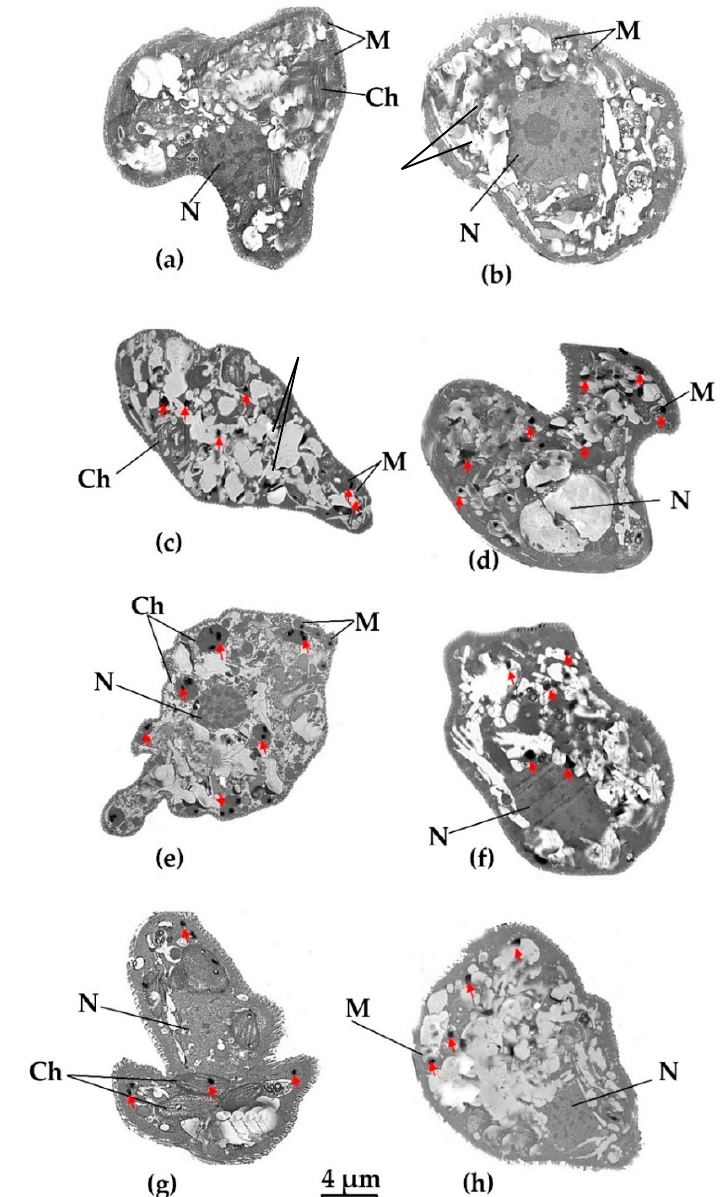
Figure 5. Visualization of heavy metal accumulation in E. gracilis strains using transmission electron microscope (TEM). ( a ) Z-strain control- untreated cell; ( b ) Zm-strain control- untreated cell; ( c ): Z-strain exposed to Hg; ( d ): Zm-strain exposed to Hg; ( e ): Z-strain exposed to Cd; ( f ): Zm-strain exposed to Cd; ( g ): Z-strain exposed to Pb; ( h ): Zm-strain exposed to Pb. P: Paramylon; N; nucleus, M; mitochondria, Ch; chloroplast. Black dots represent heavy metal inclusion and are marked by a red arrow. The 4 µm bar corresponds to all images.